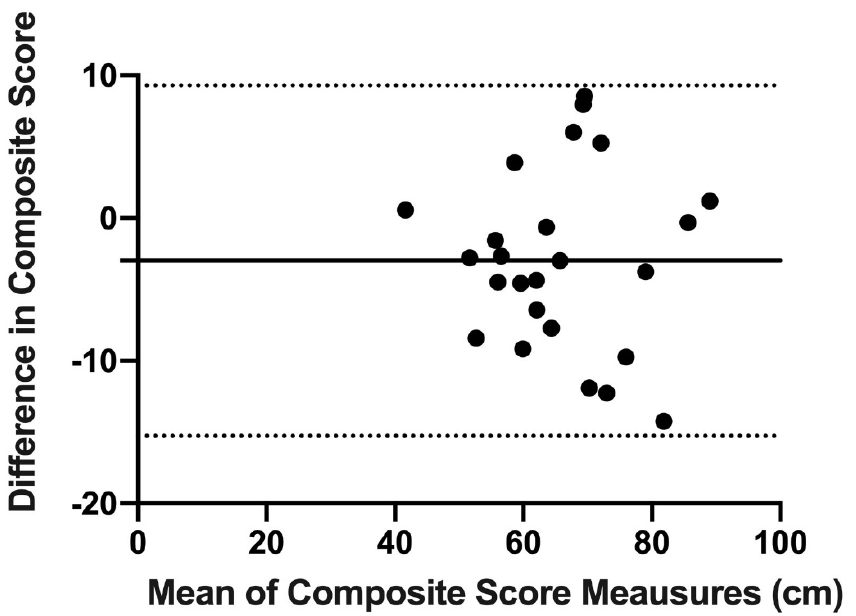
Figure 11. Bland–Altman right inferolateral.